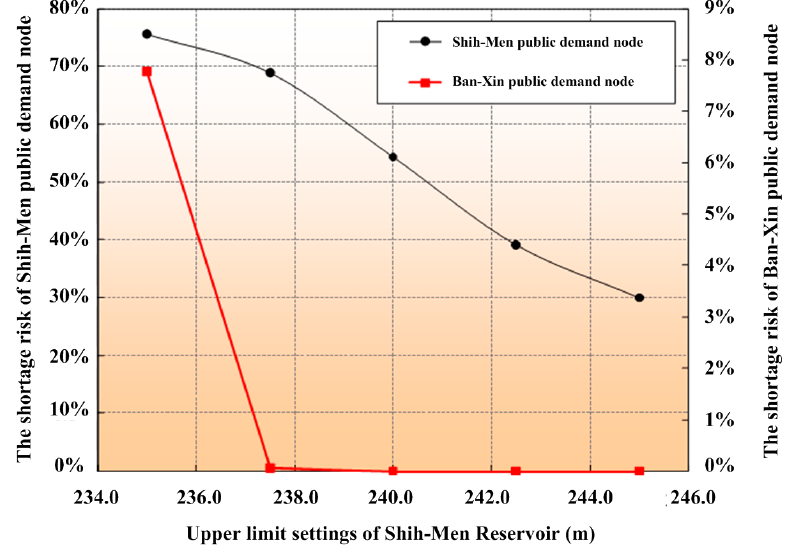
Figure 12. Shortage risk analysis during drought periods for different upper limit settings of Shih-Men Reservoir: public demand.